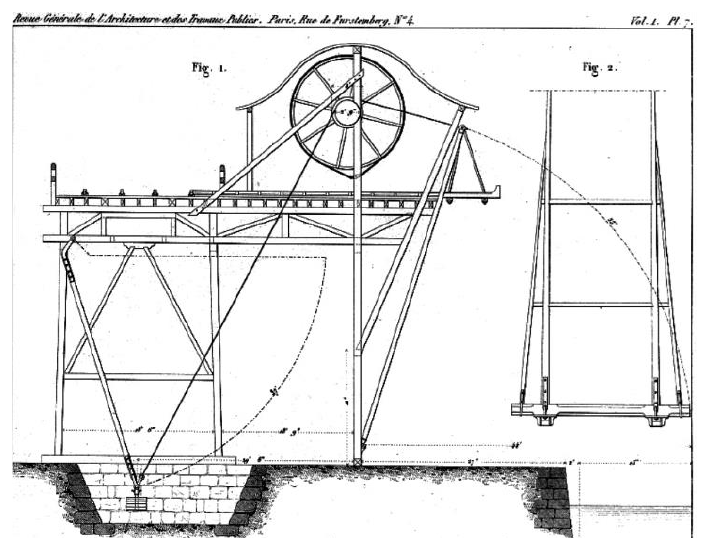
Figure 34. Detail of machinery used to ship coal in England. Engraving accompanying the article called “ Machines employed in England to ship coal ” signed by Teisserenc published in the journal “ Revue Générale de l ’ architecture et des Travaux Publics ” , France, 1840. Vol. 1, (Pl.7). Reference [61].